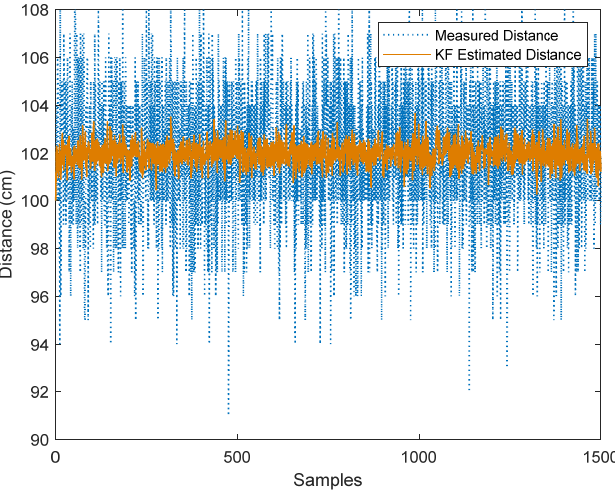
Figure 5. Comparison of the measured distance and KF estimated distance (UWB anchor 1).